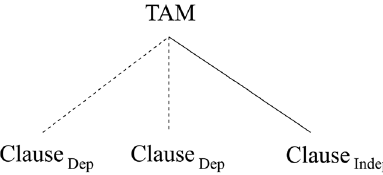
Figure 2: TAM scope over clause dependency